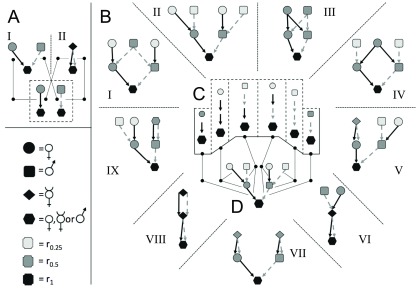
The existence of a universal set of ascendant paths in diverse genealogies.(
A) For any strictly 2-sex species, a genealogy of first-degree ascendants has only two possible states: an individual has either one mother and one father (
A I), or one selfing hermaphroditic parent (
A II). These two genealogies contain different numbers of individuals, related by different coefficients of relatedness, but they can be represented by identical set of “paths” linking parents of each sex to their offspring. In both cases a child has exactly one female parent and one male parent (as indicated within dashed-line box). The number of possible genealogies is therefore larger than the number of possible path combinations. (
B) This relationship holds at higher degrees of relatedness. At two degrees of relatedness, all 9 possible ascendant genealogies (
B; I–IX) possess a fixed set of exactly one each of the 6 paths shown in (
C). Each child has exactly one female parent, one male parent, one maternal and one paternal grandfather, and one maternal and one paternal grandmother, even if e.g., their maternal grandfather and their paternal grandfather is the same individual (as in
B I). In this way, all genealogies of any given diameter have a single invariant set of ascendant paths, independent of their actual shape. (
D) This invariant set of paths can be represented as a directed acyclic graph in which each node represents a class of relative (e.g., maternal grandfather, paternal grandfather, etc.), rather than a distinct individual. An individual may occupy more than one node (as e.g., in
B I, where the same individual is both maternal grandfather and paternal grandfather), but a node may not contain more than one individual in an ascendant lineage.